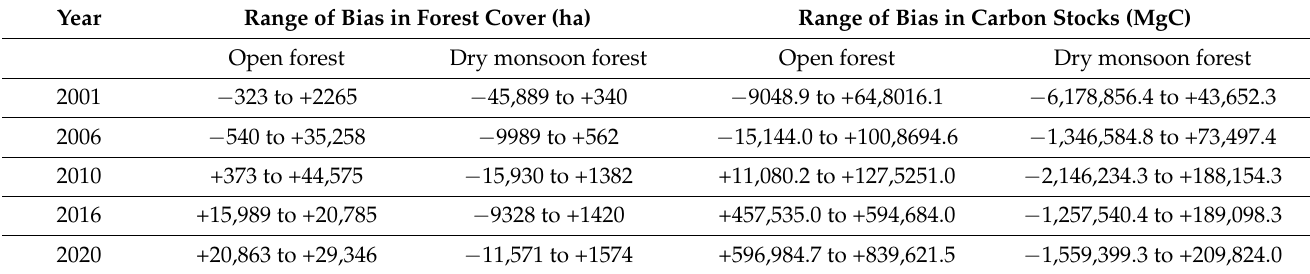
Table 9. Range the estimated forest cover and carbon stocks affected by the chosen M1, M2, and M3 models by comparing with the best-fit model for forest cover and carbon